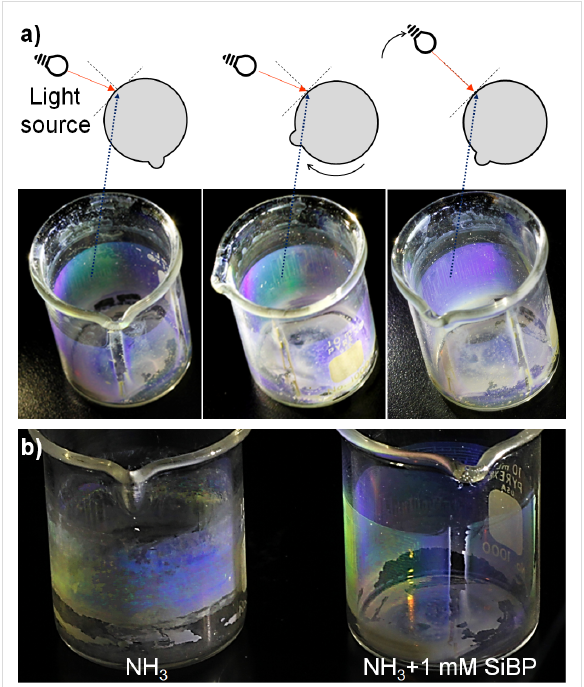
Figure 6: (a) Qualitative demonstration of the long-range homogeneity of self-assembly and angular dependence of Bragg reflection of as-synthesized SiO 2 particles formed with NH 3 + 1 mM SiBP. (b) Qual- itative comparison of the long-range homogeneity of self-assembly of as-synthesized SiO 2 particles formed with NH 3 alone and NH 3 + 1 mM